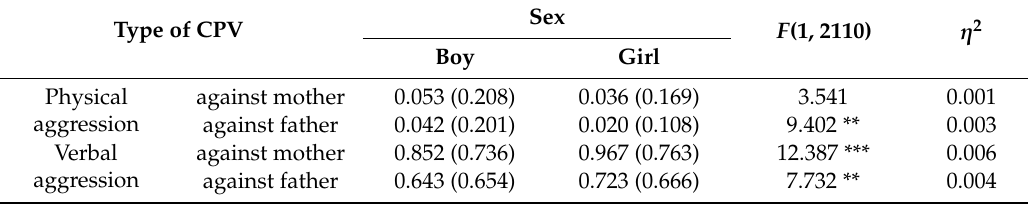
Table 5. Means, Standard deviations and di ff erences between sex and dimensions of CPV. Type of CPV